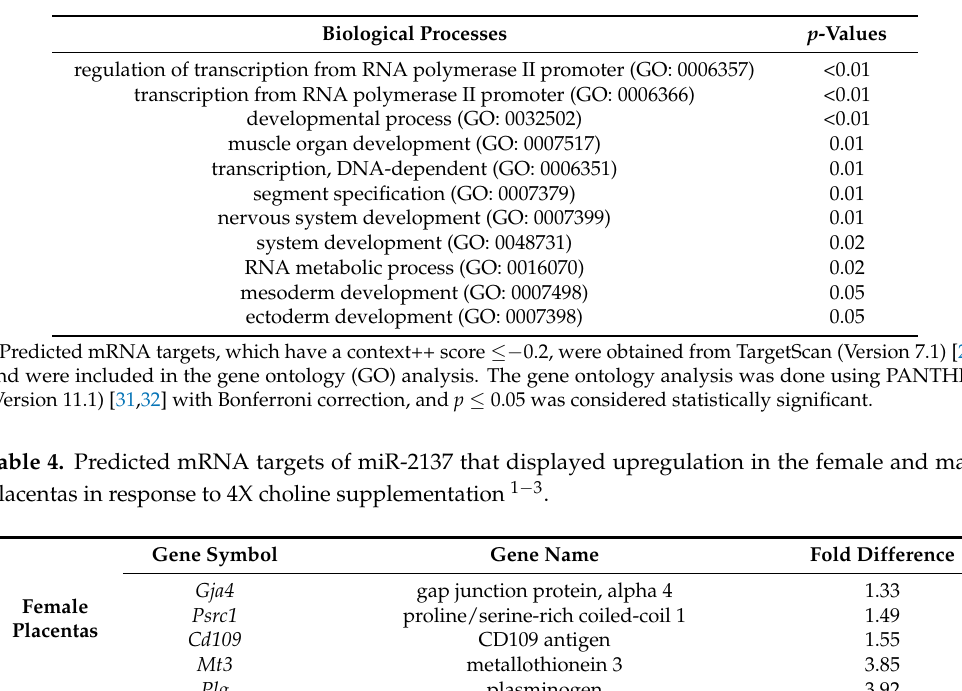
Table 3. Biological processes affected by the predicted mRNA targets of miR-2137 1 .